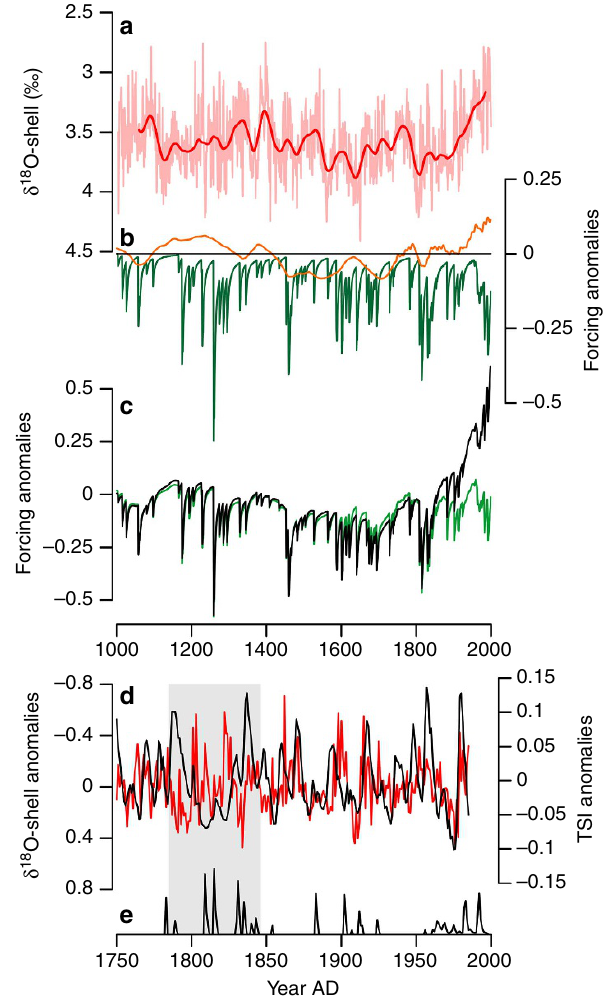
Figure 5 | The d 18 O-shell series and climate forcings. Comparison between ( a ) the inverted d 18 O-shell anomalies (annually resolved and 50-year loess low-pass-filtered data shown by the pink and red lines, respectively) with ( b ) individual climate forcing indices (TSI and volcanics shown by the orange and green lines, respectively), and ( c ) combined natural forcings (solar and volcanics; green line) and combined total forcing (solar, volcanics, greenhouse gases, aerosols; black line). ( d ) Plot of the 50-year loess first-order high-pass-filtered TSI (black line) and inverted d 18 O-shell anomalies (red line) over the period AD 1750–1997. ( e ) Timing of volcanic eruptions over the AD 1750–1997 period. The grey box highlights the 2 consecutive 30 periods following the Laki (1783) and Tambora (1815) volcanic eruptions, which probably dominate the climate signal over this period. Climate forcing data from Crowley 2